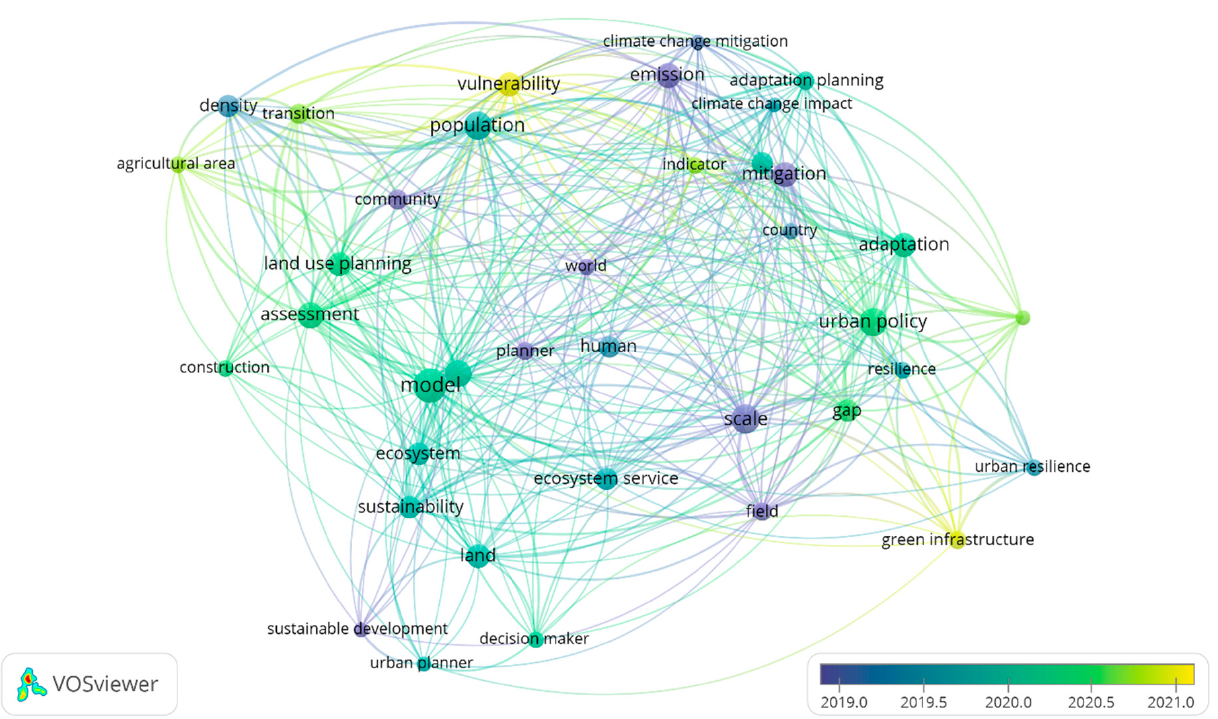
Figure 3. Co-occurrence clusters and their main terms in connection.